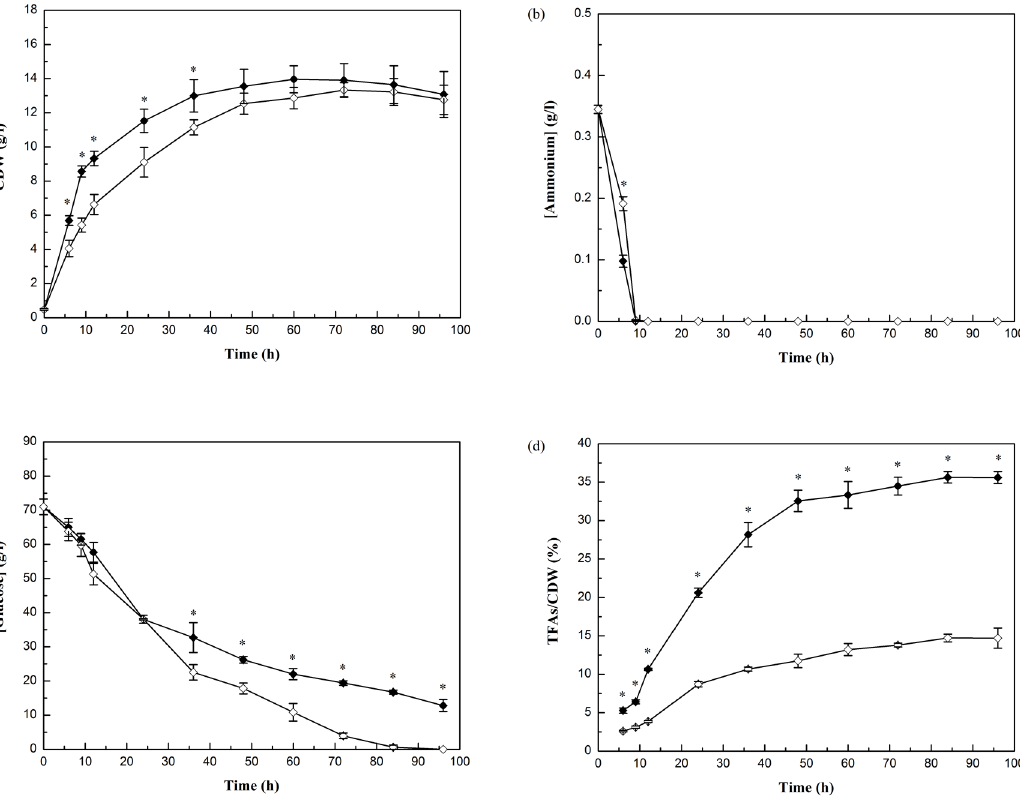
Fig 2. Cell growth and lipid accumulation of M . circinelloides WJ11 ( ◆ ) and CBS 277.49 ( (cid:3) ). (a) Cell dry weight (CDW), (b) ammonium and (c) glucose concentration in culture medium, and (d) total fatty acids (TFAs) content (w/w, TFAs/CDW) of strain WJ11 and CBS 277.49 grown in the modified K & R medium in 2L fermenter were measured. Values were mean of three biological replicates. Error bars represent the standard error of the mean. * P < 0.05 significantly different between the two strains.